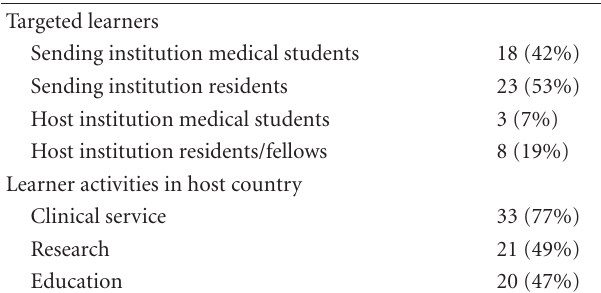
Table 1: Targeted learners and type of activities in host country. Targeted learners